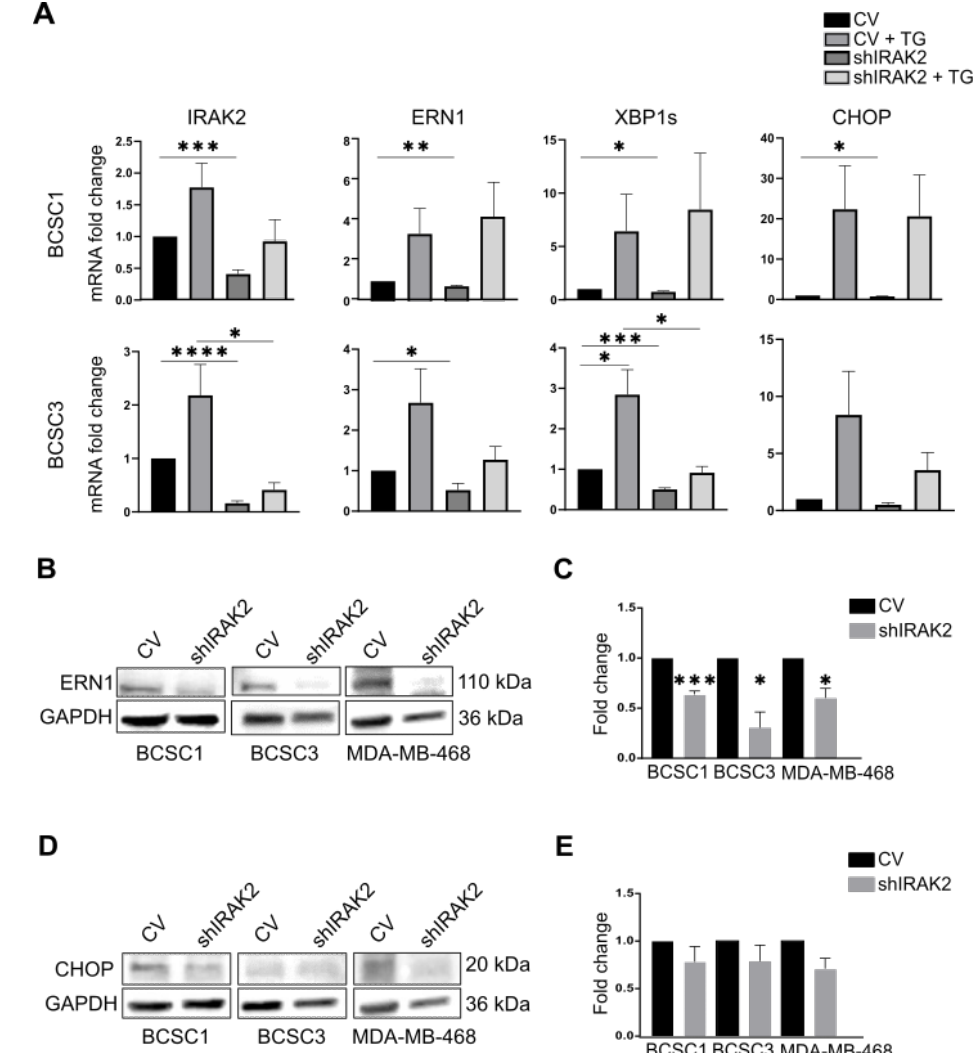
Figure 3. In the presence of ER-stress, IRAK2 is upregulated, and its downregulation affects the ERN1 pathway. ( A ) Expression of IRAK2, ERN1, XBP1s and CHOP at the mRNA level in control and IRAK2 knockdown BCSC1 and BCSC3. The transcription of the genes was evaluated in control cells (CV), control cells treated with thapsigargin (CV + TG), IRAK2 knockdown cells (shIRAK2) and IRAK2 knockdown cells treated with thapsigargin (shIRAK2 + TG). All cells (thapsigargin-treated and untreated, control and shIRAK2 cells) were cultured in the presence of doxycycline. Cells were harvested, and RNA was isolated from their pellet. The gene of interest (IRAK2, ERN1, XBP1s and CHOP) expression was normalised to the HKG β -actin. The relative expression was calculated using the 2 − ∆∆ CT method and represented as the normalised quantity of mRNA in shIRAK2 cells, CV + TG cells and shIRAK2 + TG cells relative to the normalised quantity of mRNA in CV cells, which was set as 1. ( B – E ) The expression of ERN1 ( B ) and CHOP ( D ) at the protein level and their relative quantification (( C ) for ERN1 and ( E ) for CHOP) in the CV and shIRAK2 BCSC1, BCSC3 and MDA-MB-468. Cells were cultured for 5 days in a medium containing 100-ng/mL doxycycline, harvested, and the proteins were subsequently isolated from the cell pellet. The expression of the gene of interest (ERN1 or CHOP) was normalised to the expression of glyceraldehyde-3-phosphate dehydrogenase (GAPDH). Subsequently, the expression evaluated in shIRAK2 cells was compared with that calculated in CV cells, which was set as 1. Data (n = 3) are presented as means ± SEM using unpaired Student’s t -test. *, p < 0.05; **, p < 0.01; ***, p < 0.001; ****, p <